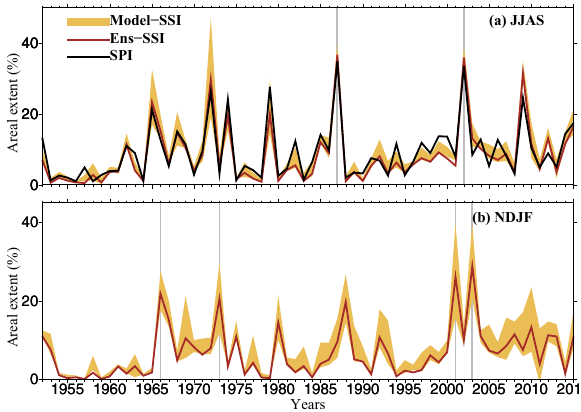
Figure 2. Uncertainty in areal extent (%) of 60cm soil mois- ture drought simulated using the three LSMs (i.e. VIC, Noah, and CLM). (a) Multi-model ensemble (brown) mean 4-month Standard- ized Soil Moisture Index (SSI) and inter-model variation (shaded) estimated as 1 standard deviation for the monsoon season. The black line in (a) shows the 4-month Standardized Precipitation In- dex (SPI) at the end of the monsoon season (June through Septem- ber), (b) and multi-model ensemble mean and uncertainty in the 4-month SSI estimated using the three LSMs for the Rabi season (November through February). The light brown shaded area shows uncertainty in severe-to-exceptional drought based on the model simulated SSI (SSI < − 1.3). The dark brown line shows areal extent estimated based on the ensemble mean SSI for the three LSMs. The grey line marks the top drought years based on area under